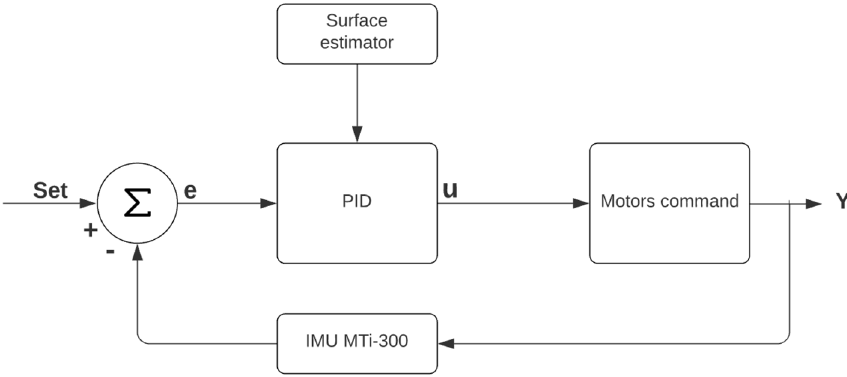
Figure 8. The PID controller used for the closed-loop system used to generate motors